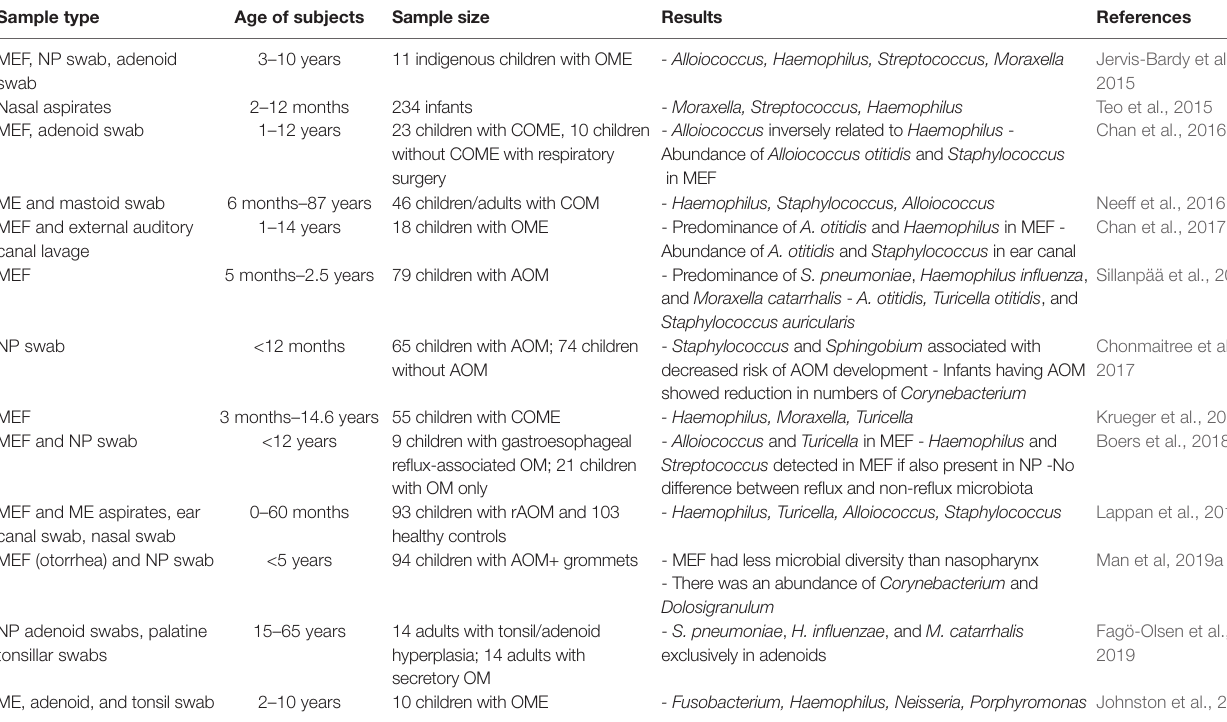
TABLe 4 | A summary of studies determining microbiome of upper respiratory tract in individuals susceptible to otitis